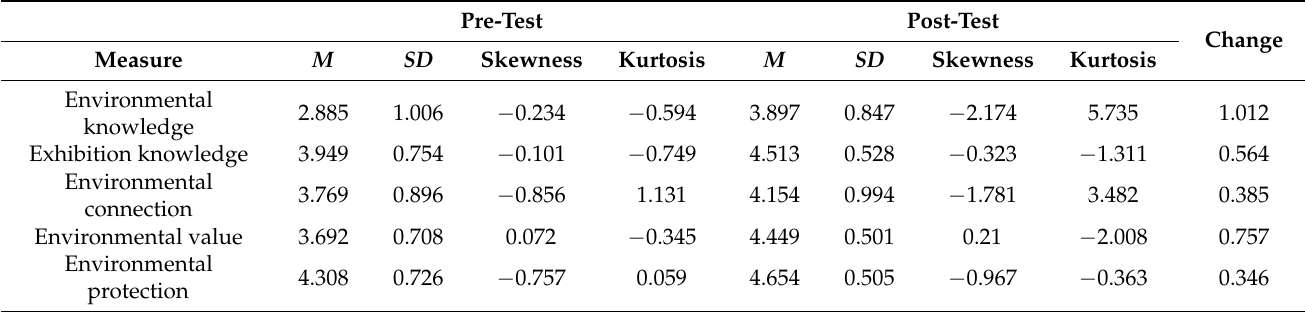
Table 5. Summary of descriptive statistics for environmental knowledge and beliefs ( n =